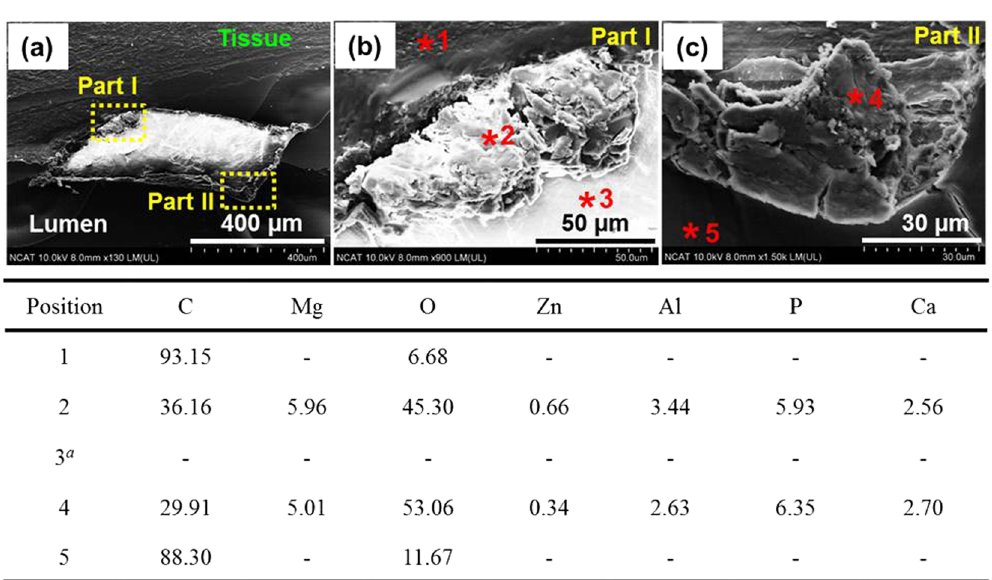
Figure 7. SEM images and EDX analysis of corrosion products surrounding expanded helical stents under the flow induced wall shear stress value of 0.154 Pa for 3 days in DMEM (10% FBS, 1% P/S) at 37 °C, 5% CO 2 . a Indicates Mg-based helical stent has been